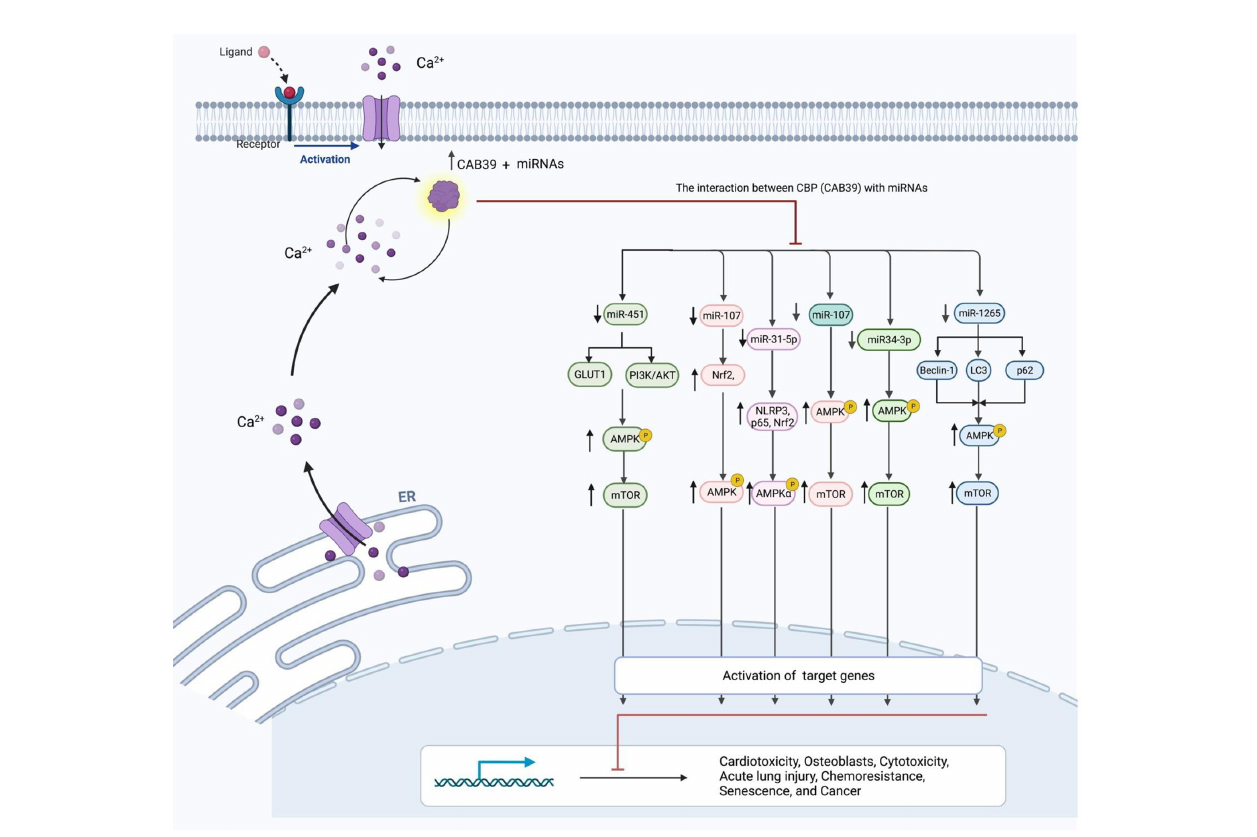
FIGURE 1 | The connection between CAB39 and miRNAs, as well as their role in human diseases. Inhibition of miRNA has resulted in increased CAB39 levels and increased activity of AMPK pathway. Cab39 has therefore been found as a miRNAs target, and these miRNAs modulate cardiotoxicity, osteoblasts, cytotoxicity, acute lung damage, chemoresistance, senescence, and cancer development through this